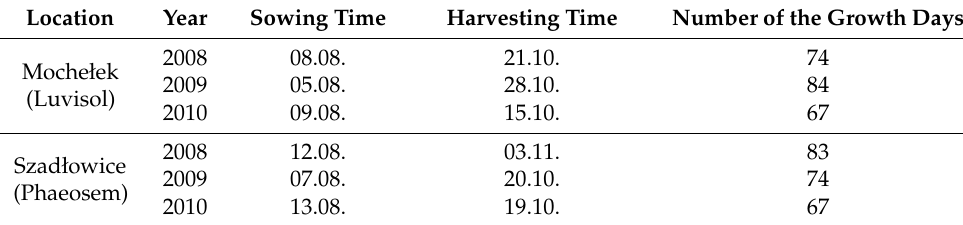
Table 1. Sowing and harvesting times of catch crops.